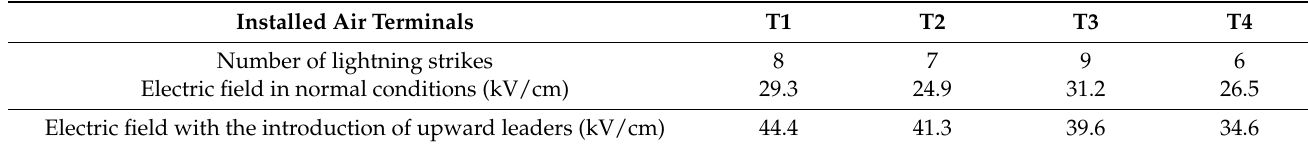
Figure 15. Probability of lightning strike on different points of a cylindrical structure ( a ) field value for normal pre-breakdown conditions, ( b ) field value for upward leader inception. Table 7. Number of strikes and electric field on the LATs of a cylindrical